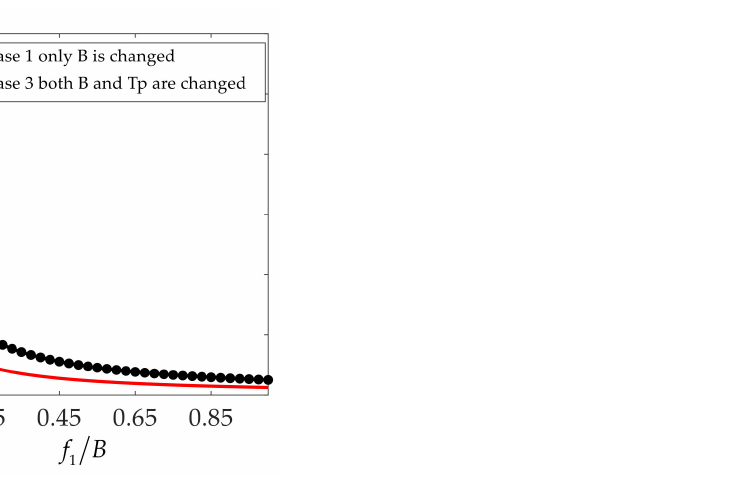
Figure 4. Degradation of radar range resolution vs. jammer frequency shift relative to